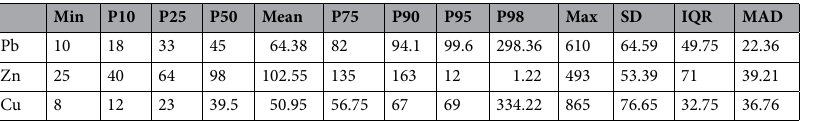
Table 2. Summary of the main statistical parameters (unit of measure (UM), minimum (Min.), maximum (Max.), percentiles (P) 10, 25, 50, 75, 90, 95, 98, mean, standard deviation (SD), interquartile range (IQR) and median absolute deviation (MAD) of Pb, Zn and Cu measured contents.